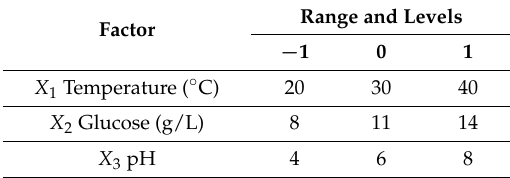
Table 2. Levels of variables tested in Box Behnken Design (BBD) for optimization of protease production. Range and Factor